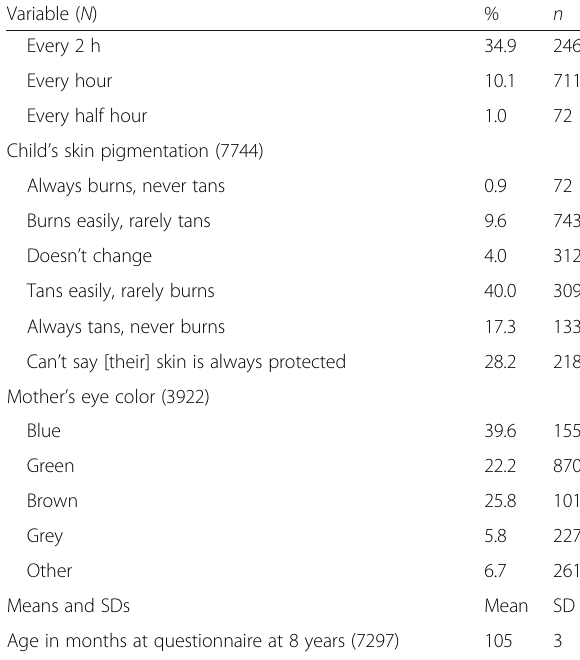
Table 1 Sex, age, sun exposure and pigmentation of the children and mothers in the study population